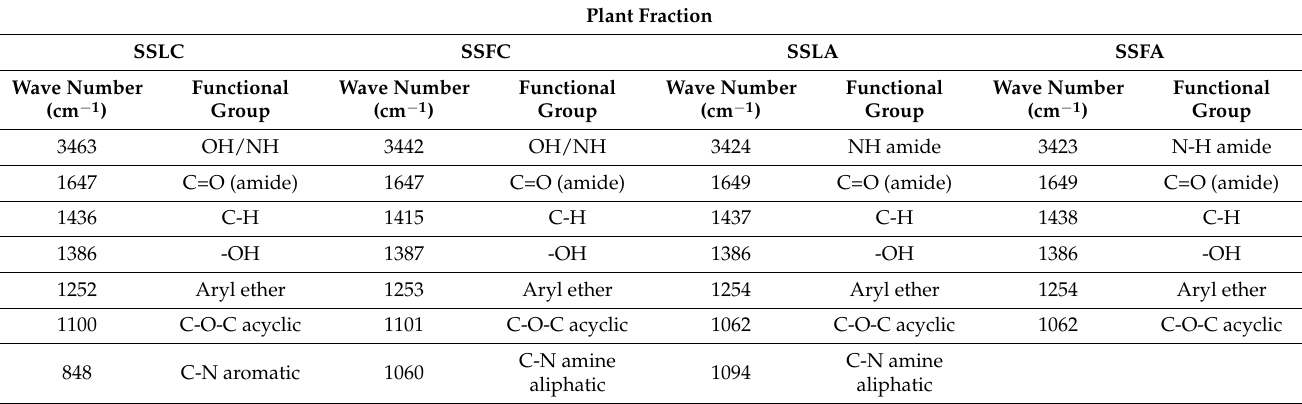
Table 2. Fundamental IR vibrations of phytochemicals present in S. surrattense fractions.